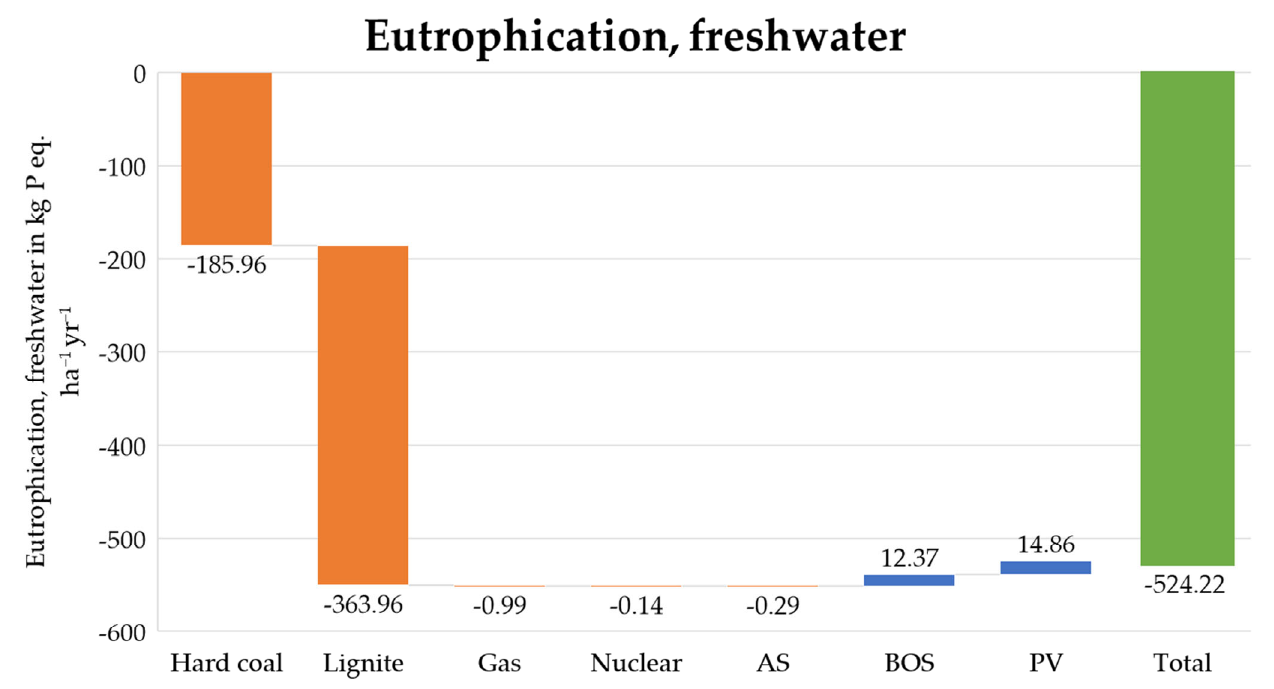
Figure 4. Environmental impact of the change of 1 ha single ‐ use agriculture to an overhead AVS in Germany in the category eutrophication, freshwater per year (AS: agricultural system, BOS: balance of system, PV: PV modules).